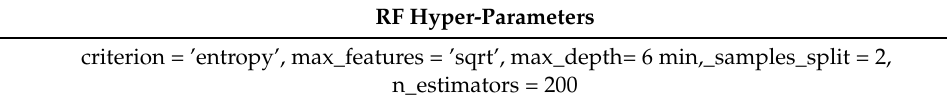
Table 3. Grid Search parameters for the RF model.